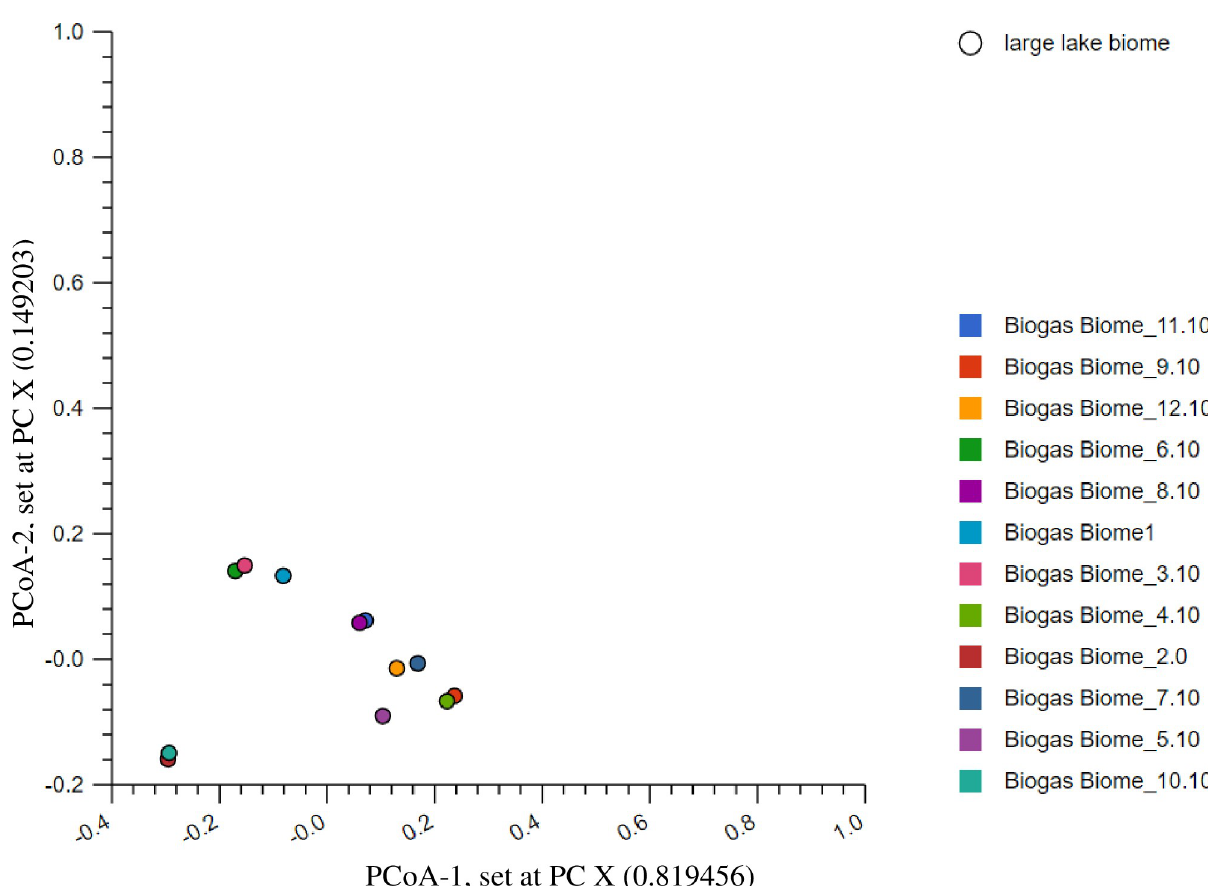
Fig 5. The PCoA analysis revealing β -diversities of the twelve treatments at the order level. The reads compositions in reactor 2 and 10 were partially similar, located in the lower left quadrant, those in reactor 8 and 11 located in the upper right quadrant, reactor 4 and 9 in the lower right quadrant, while those in reactor 3 and 6 were located in the lower left quadrant of the